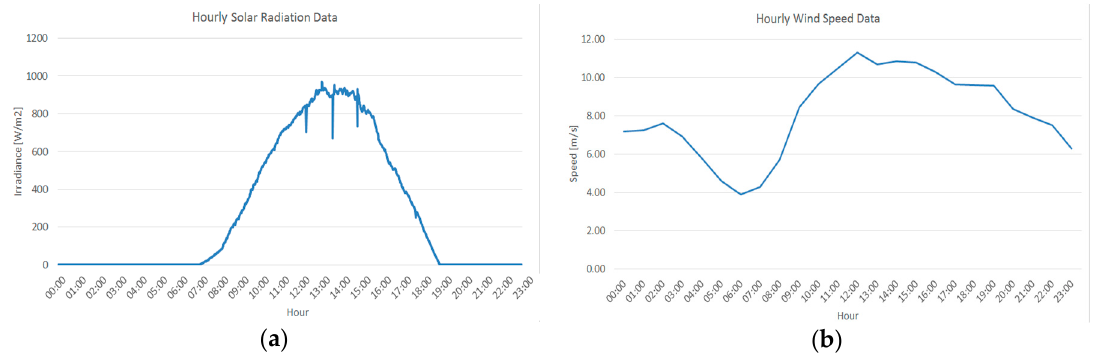
Figure 15. Hourly ( a ) solar irradiance and ( b ) wind speed data on a typical day.